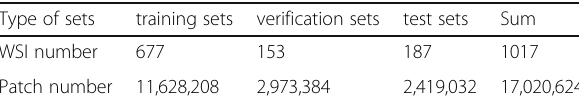
Table 1 The results of segmentation and extraction based on 1017 HE slices labelled information Type of sets training sets verification sets test